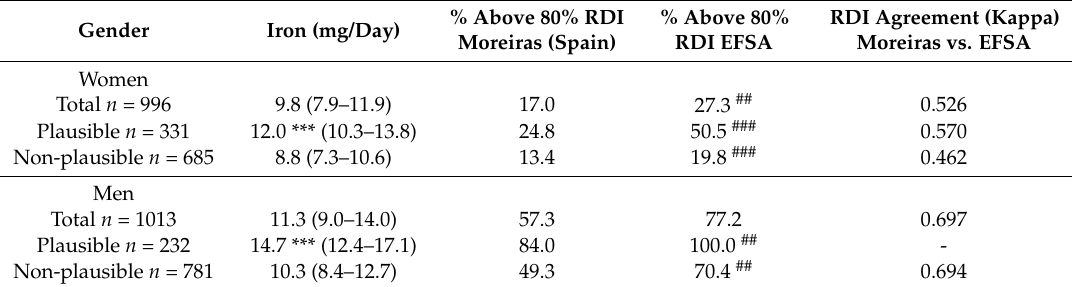
Table 4. Iron intake (mg/day) and prevalence of adequate (% population above 80% RDI) in ANIBES sample by gender and reporting and agreement (k) between Spanish [12] and EFSA references